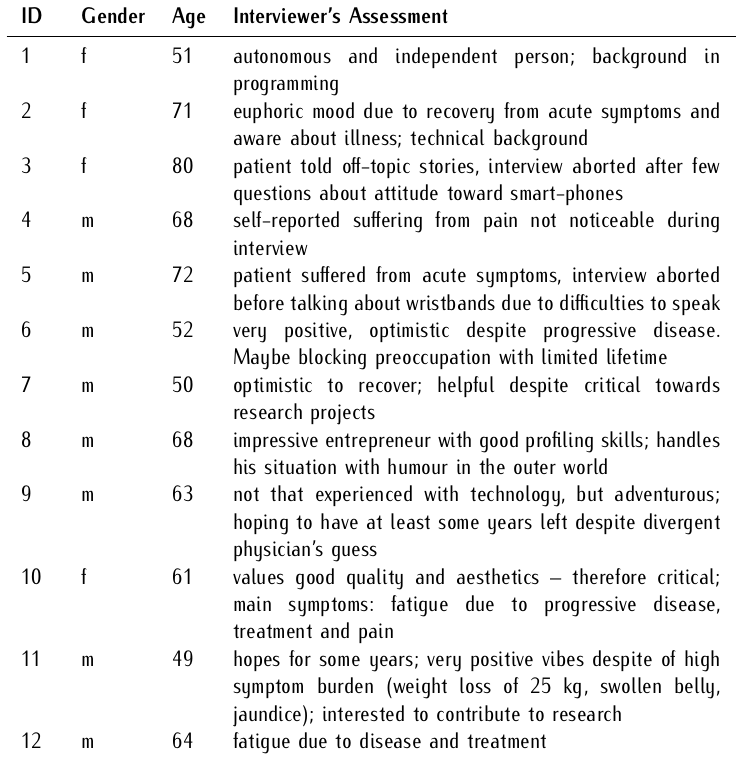
Table 3. List of Interviewed Patients; f=female,